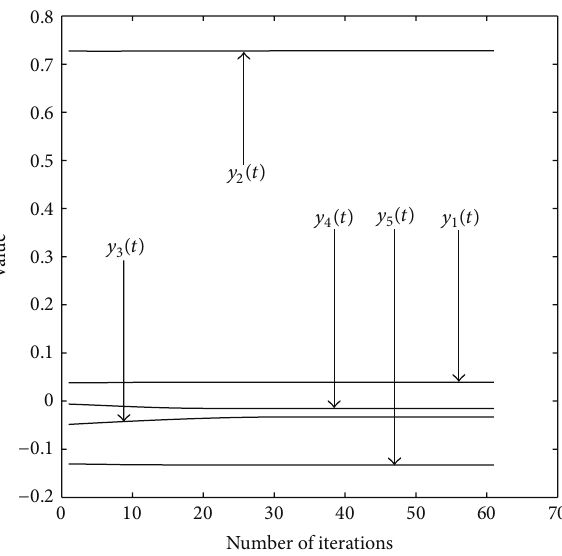
Figure 14: Trajectories of 𝑦(𝑡) = (𝐴 𝑝 − 𝐴 𝑇 𝑝 )𝑥(𝑡)/2𝑏 2 based on (10) with initial 𝑥(0) as (65), which should converge to the real part of an eigenvector of 𝐴 𝑝 corresponding to the eigenvalue 𝜆 2 .